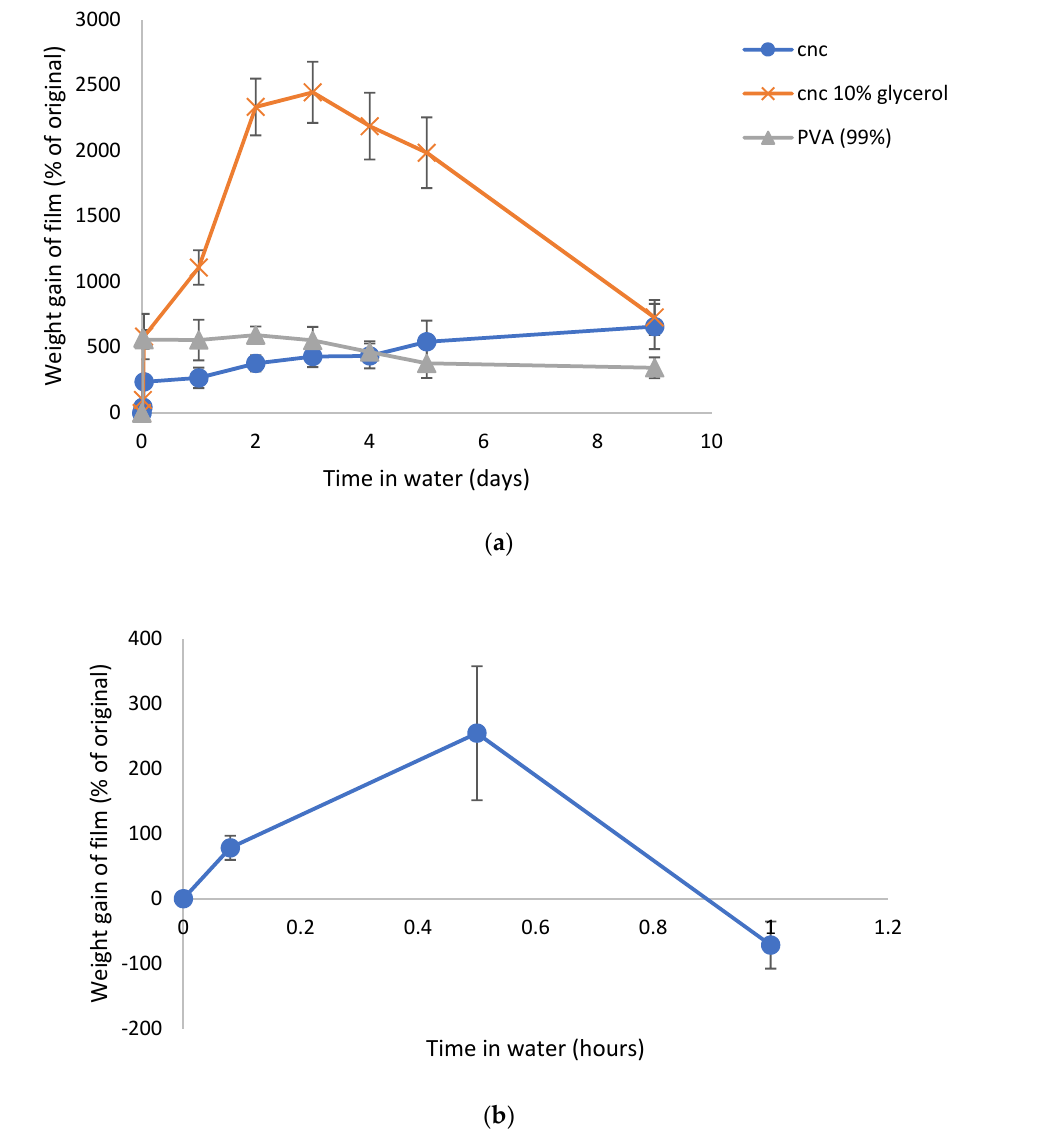
Figure 2. ( a ) Time course of swelling of SDF loaded CNC or PVA hydrogel films in water. ( b ) Time course of swelling of SDF loaded PVA (88% hydrolyzed) films in water.